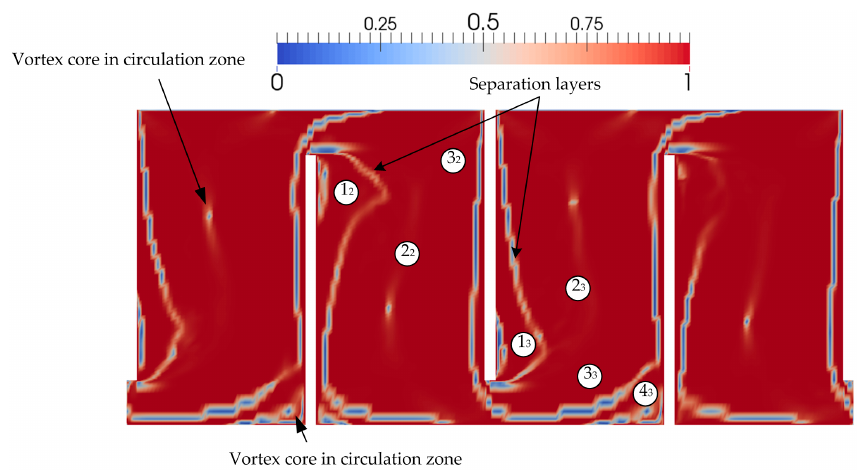
Figure 13. Contour plot of the magnitude of the dimensionless Lamb vector on the x – y plane at mid span ( z = L /2) for RANS.